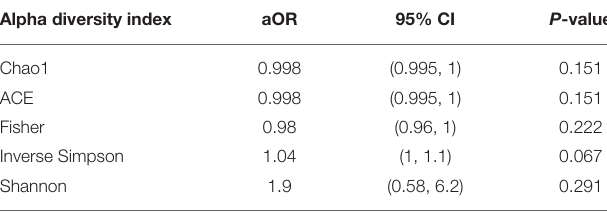
TABLE 3 | Association of alpha diversity indices with Campylobacter isolation status of